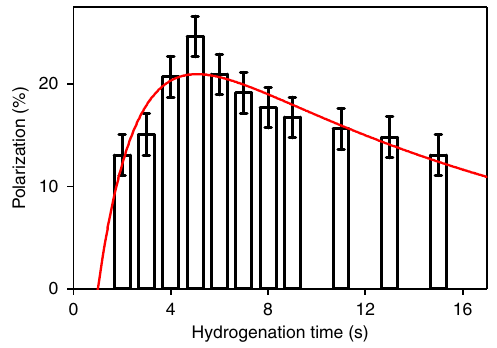
Figure 6 | Hydrogenation time affects polarization. Mean 13 C-HP (columns) and s.d. (error bars) of HEP (1- 13 C HEP) as a function of hydrogenation time ( t h ) and fit (line). In agreement with earlier reports 18 , the optimum t h was between 4–8s. The time constants for the catalytic hydrogenation reaction, T cat ¼ (1.6 ± 0.9) s, and the para -order relaxation, T para ¼ (16 ± 6) s, were extracted from a model fitted to the data. The model is described in Methods (equation (2)). Each time point was measured three times.